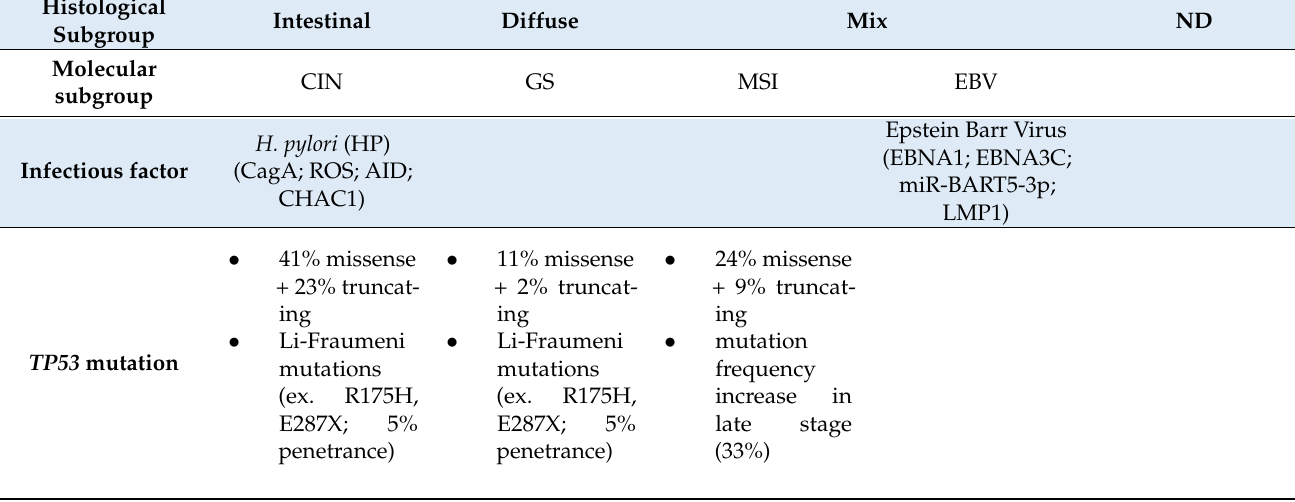
Table 1. Molecular alterations in the p53 family and related pathways present in gastric cancer.